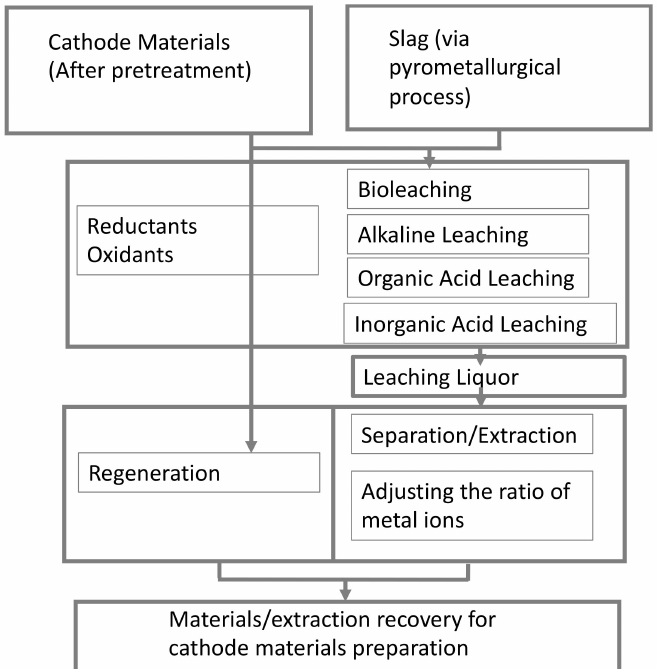
Figure 10. Conventional hydrometallurgical recycling and recovering processes for spent Li-ion batteries (Data gathered from ref.